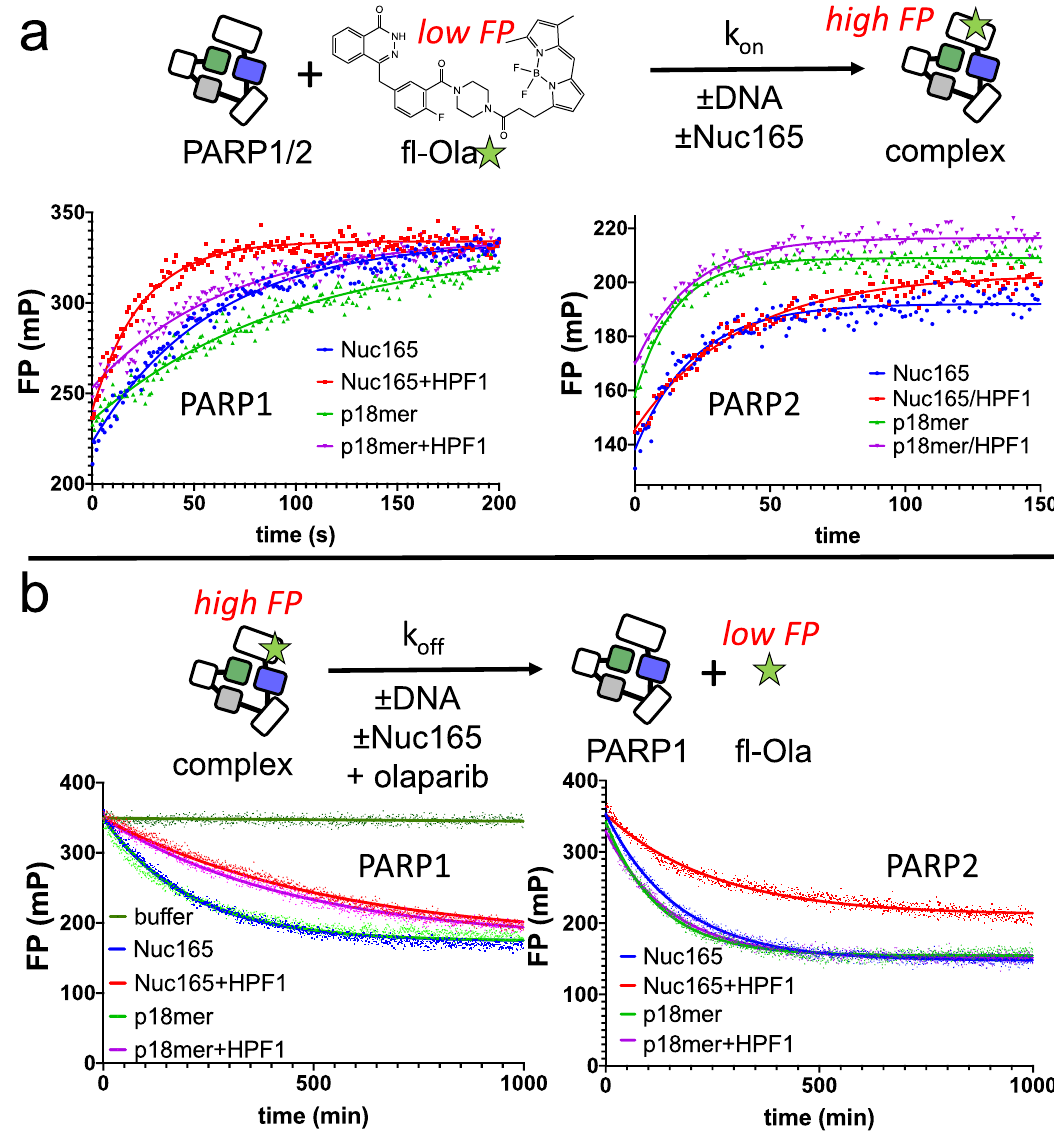
Fig. 4 HPF1 increases the af fi nity of fl -Ola for PARP1 but not PARP2. a Top: Schematic for the FP assay used to monitor association of fl -Ola with PARP1 and PARP2. Below: Representative data for monitoring the association of fl -Ola with PARP1 and PARP2 in the presence or absence of p18mer, Nuc165, and/ or HPF1. Note the visibly faster association of fl -Ola to PARP1 when HPF1 is present. For PARP2, the association of fl -Ola is slowed in the presence of HPF1. Measured k on from replicates are shown in Table 2. b Top: Schematic for the FP assay used to monitor dissociation of fl -Ola from PARP1 and PARP2. Below: Representative data for monitoring the dissociation of fl -Ola from PARP1 and PARP2 in the presence or absence of p18mer, Nuc165, and/or HPF1. Note the visibly slower dissociation of fl -Ola from PARP1 when HPF1 is present. For PARP2, the dissociation of fl -Ola is subtly slowed in the presence of HPF1. Measured k off from replicates are shown in Table